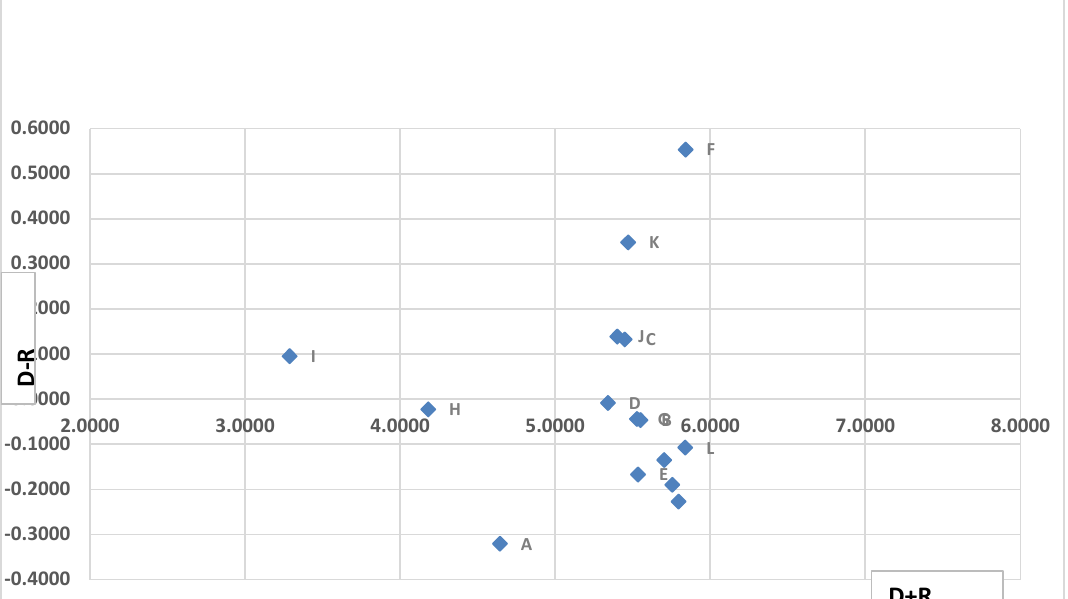
Fig. 2. Cause-effect